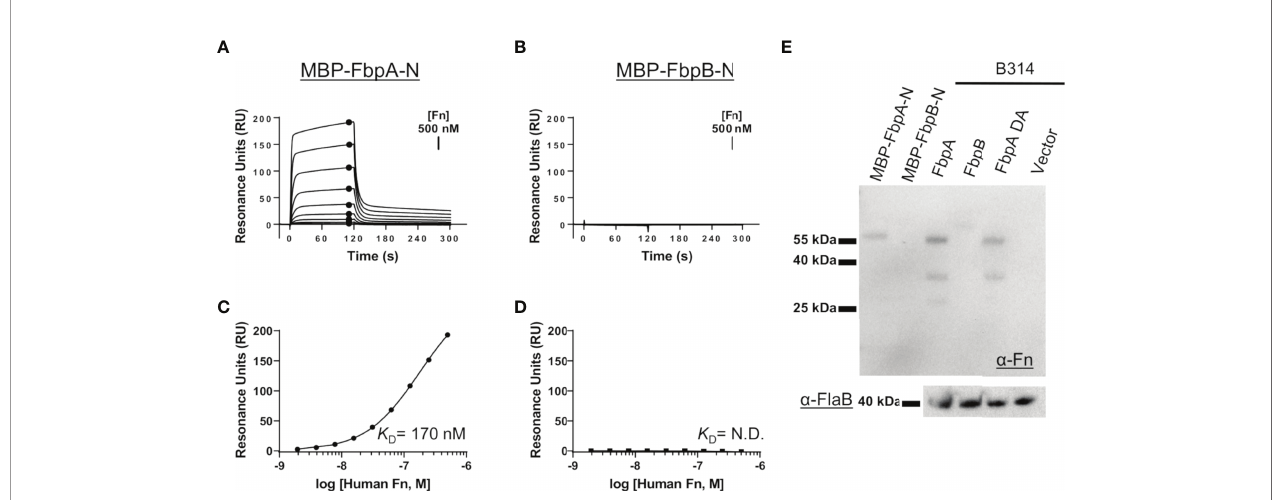
FIGURE 2 | Assessing the interaction of human fi bronectin with B. miyamotoi FbpA and FbpB. (A, B) SPR was used to quantitatively measure the interaction between FbpA-N (A) and FbpB-N (B) with human fi bronectin. MBP-Fbp-N fusion proteins (Fbp sequences denoted by green box in Figure 1B ) were immobilized on a sensorchip using amine coupling, then a twofold dilution series of puri fi ed human fi bronectin ranging from 1.95-500 nM was injected. A representative sensorgram from the three replicates for each biosensor surface is shown. (C, D) Equilibrium dissociation constants ( K D ) were determined using steady state fi ts and are shown as the mean +/- standard deviation of three replicates in Table 4 for FbpA (C) and FbpB (D) . Closed circles in (A) correspond to the steady-state response used for calculation of the steady state fi ts in (C) , respectively. A K D value for the fi bronectin interactions with MBP-FbpB-N was not determined (N.D.). (E) To assess if full- length Fbp proteins were capable of binding fi bronectin, a Far Western approach was implemented by probing full-length Fbps from B. burgdorferi strain B314 “ knock-in ” lysates with fi bronectin. Full-length FbpB fails to interact with fi bronectin, whereas FbpA and FbpA DA do. A spirochete transformed with shuttle vector only (pBBE22 luc ) and recombinant MBP-FbpA-N/MBP-FbpB-N were used as controls. A Western blot against the fl agellar protein FlaB ( a -FlaB) was used as a loading